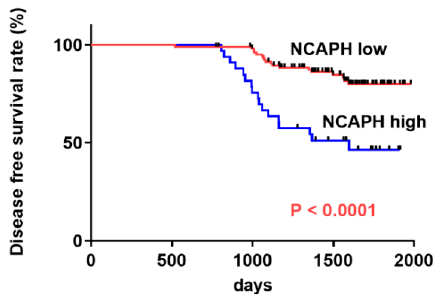
Figure 2. Disease-free survival (DFS) curve in patients with OSCC. The high NCAPH expression group had significantly worse DFS than the low NCAPH expression group ( p < 0.0001). Table 2. Univariate and multivariate analysis of disease free survival.